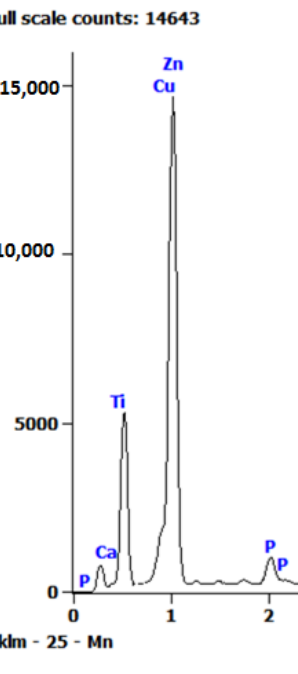
Figure 4. Chemical composition by EDS.